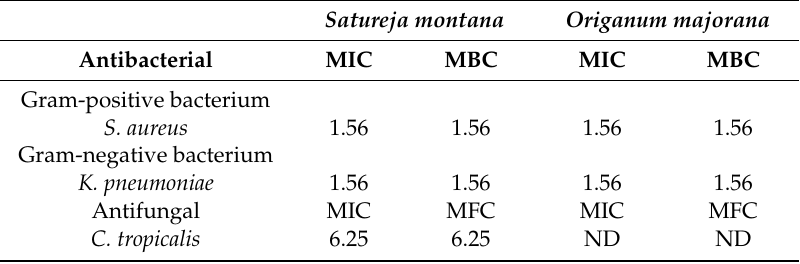
Table 2. Minimum inhibitory concentration (MIC) and minimum bactericidal / fungicidal concentration (MBC / MFC) (mg / mL) of Satureja montana and Origanum majorana decoctions against S. aureus , K. pneumoniae, and C. tropicalis , determined using the Clinical and Laboratory Standards Institute (CLSI) broth microdilution method.